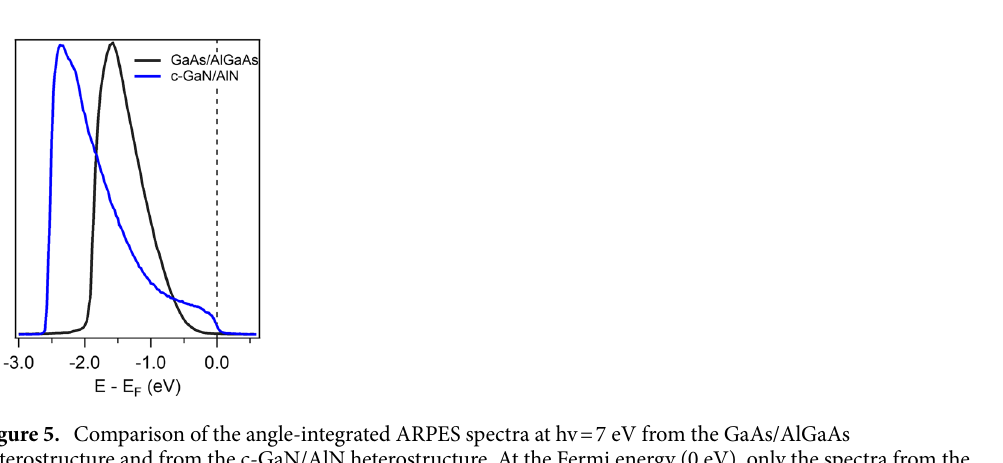
Figure 4. ARPES measurements of the GaAs/GaAlAs system. ( a ) ARPES spectrum at hv = 21 eV. ( b ) 2nd derivative of the ARPES spectrum in ( a ), displayed for better visualization of the spectral features. ( c ) Angle- integrated ARPES spectra at hv = 7 eV and hv = 21 eV.